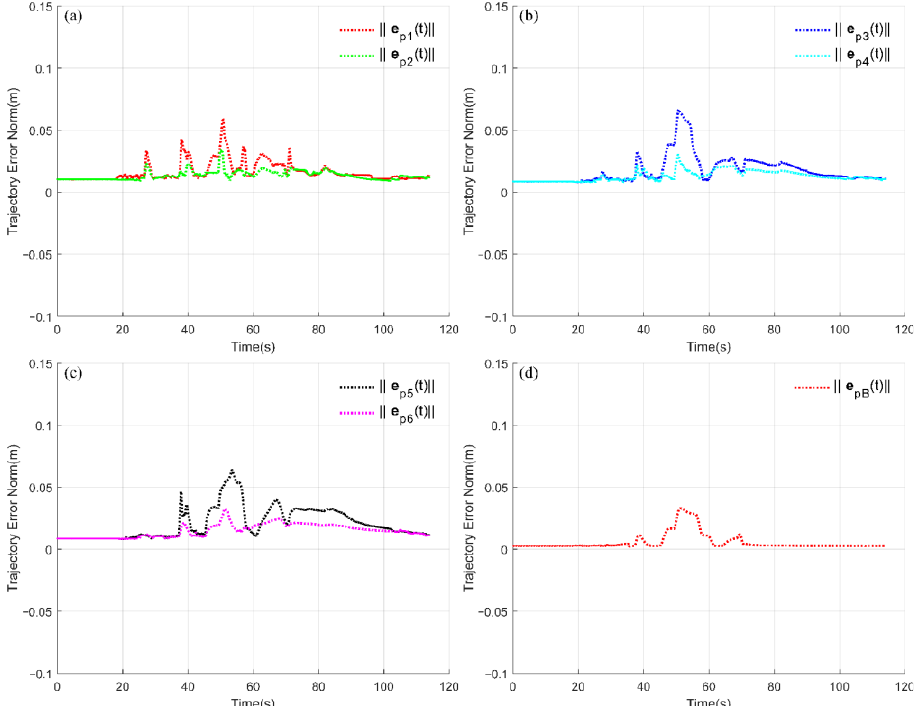
Figure 9. Tracking accuracy analysis in single-sided step scenario. Subfigure ( a ) indicates the error norms of the front flipper. Subfigure ( b ) indicates the error norms of the middle flipper. Subfigure ( c ) indicates the error norms of the rear flipper. Subfigure ( d ) indicates the error norm of the center of mass.